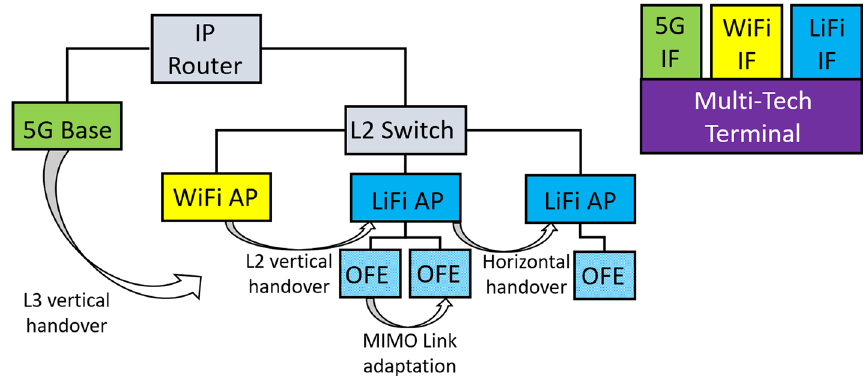
Table 1 Handover definitions between LiFi, Wi-Fi and 5G Term Description/definition MIMO link adaptation Horizontal handover between non-overlapping and overlapping areas L2 vertical